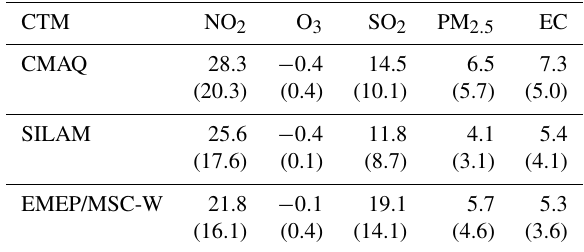
Table 3. Relative ship contribution to the spatial average of annual mean NO 2 , O 3 , SO 2 , PM 2 . 5 and EC in percent for the study do- main (Baltic Sea region as in Fig. 1). Values in brackets denote the average relative ship contribution in the coastal land areas of the